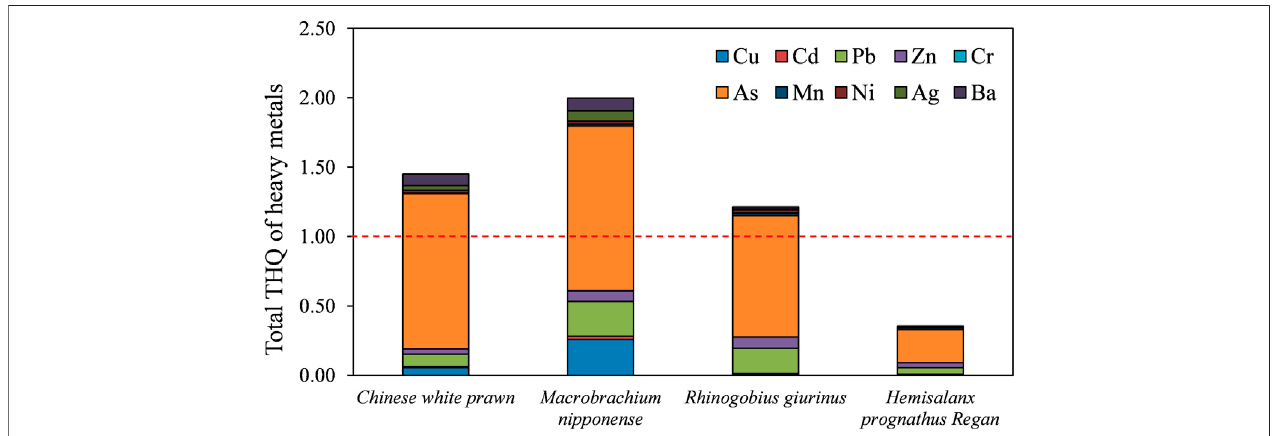
FIGURE 7 | Contributions of THQ to TTHQ for the 10 selected heavy metals via consumption of four aquatic species collected from Dianchi Lake. Red dash line indicated the acceptable total THQ threshold value ( < 1).